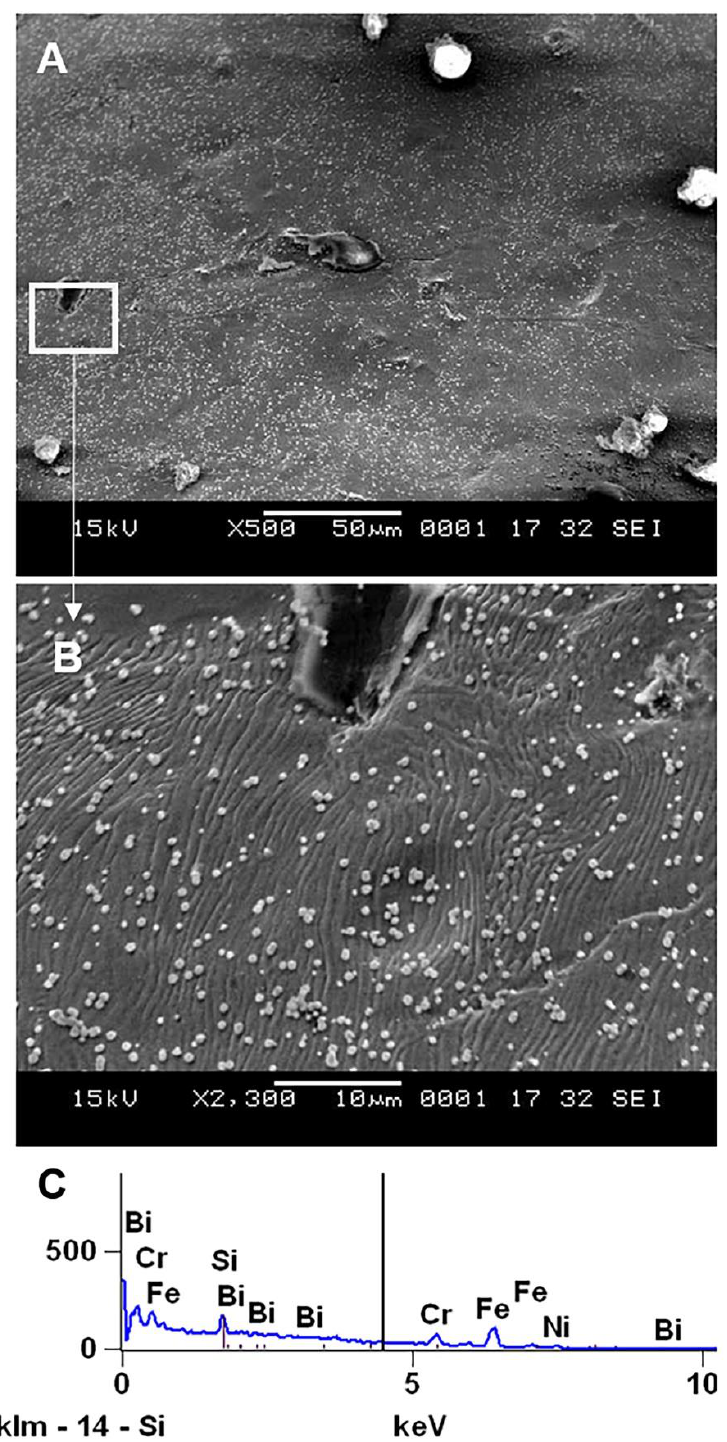
Figure 14. ( A ) Residual foreign particles with sandblasting followed by electropolishing (experi- ment 1B). ( B ) Further magnified rectangular region indicated on ( A ). ( C ) EDX analysis of these particles.